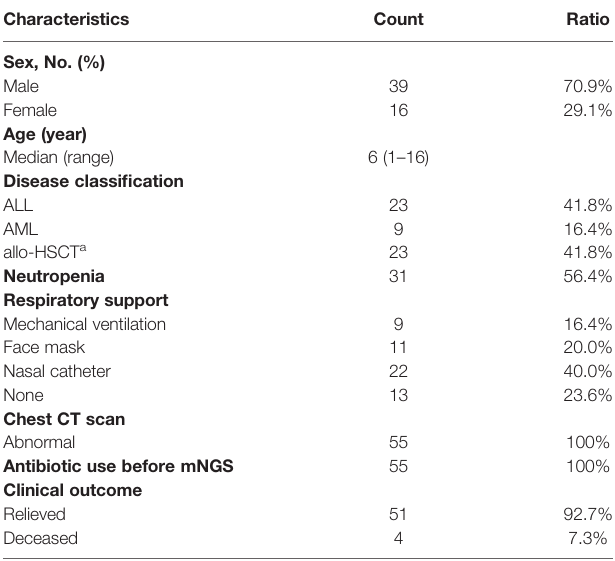
TABLE 1 | Clinical characteristics of pediatric